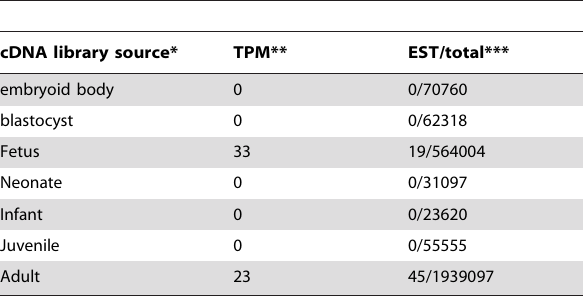
Table 5. EST profiles of DIA1R gene expression during human